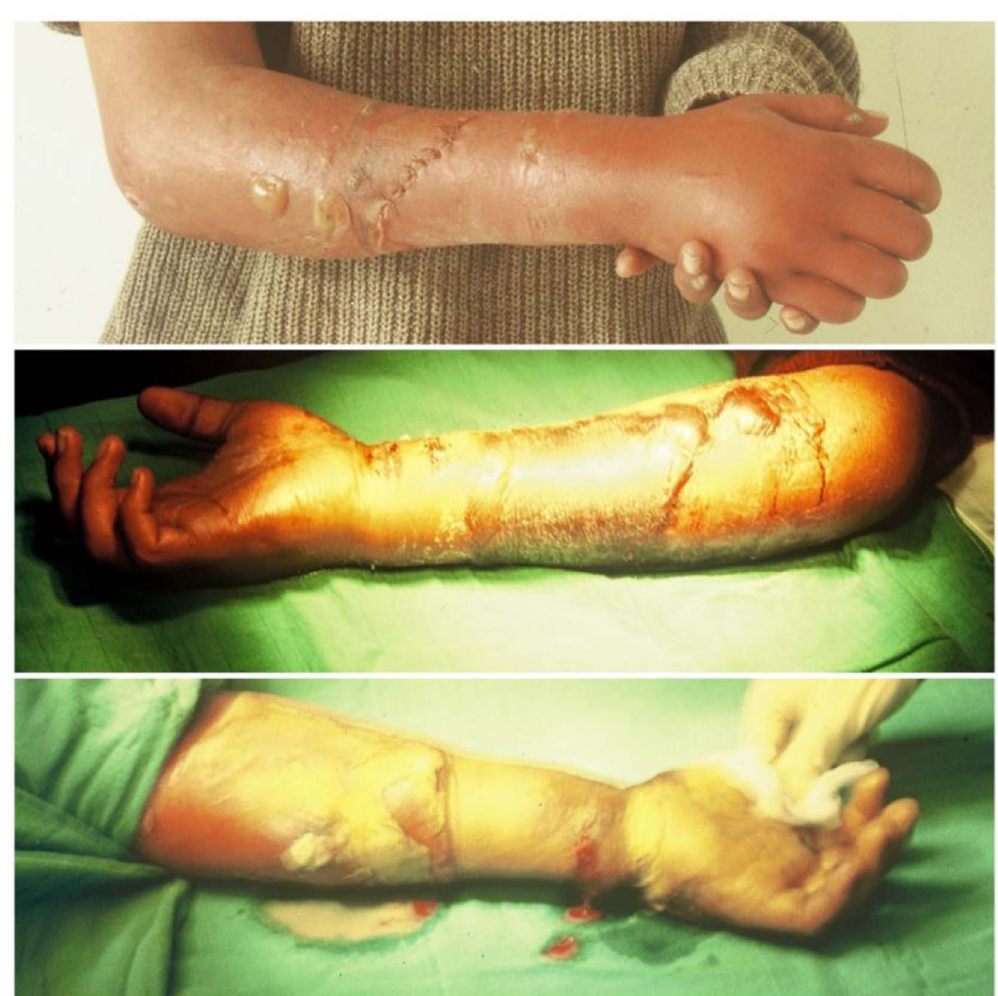
Figure 4. Three complicated cases: two Infections with common germs and one gangrene complication (bottom picture) at fi rst